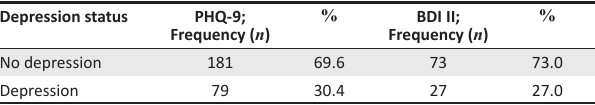
TABLE 4: Prevalence of depression among study